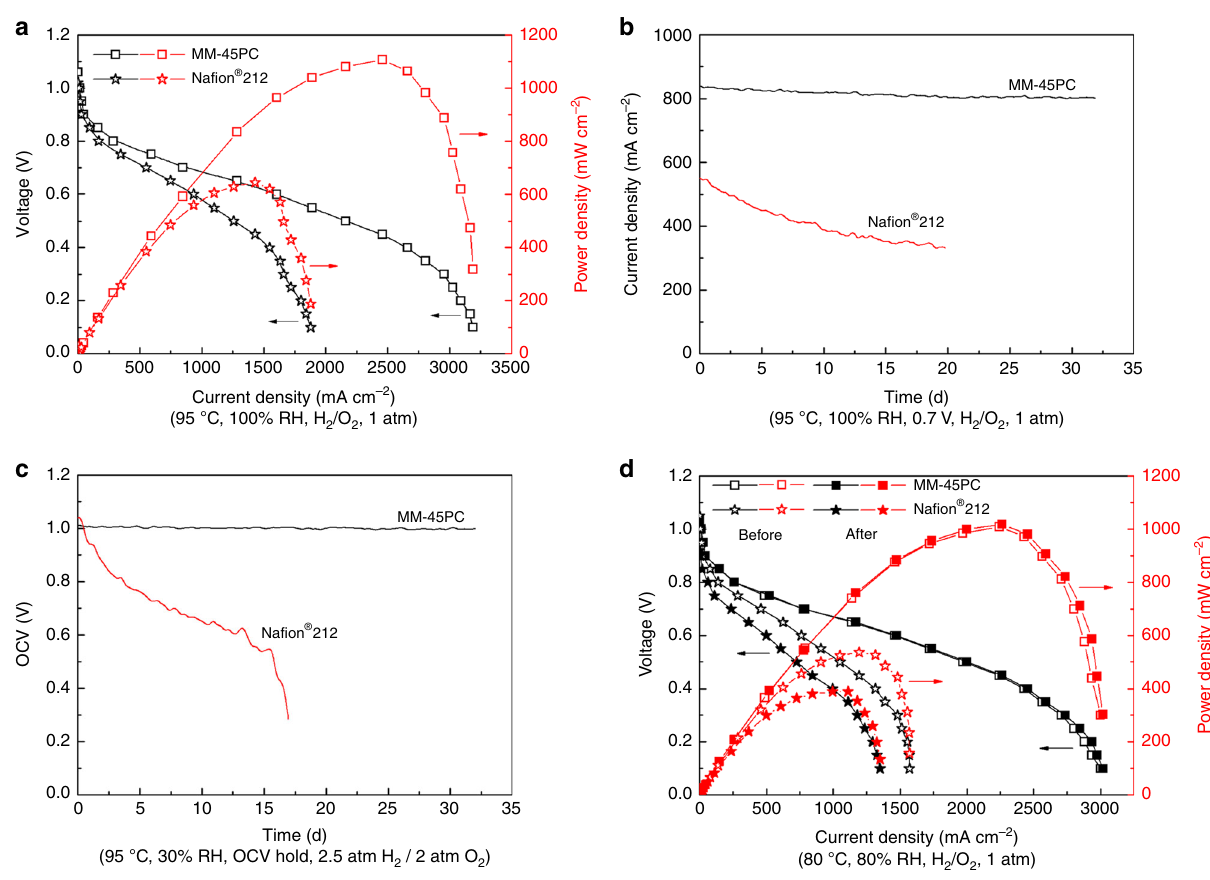
Fig. 10 Comparative performance and durability. PEMFC performance and durability derived from MM-45PC and Na fi on ® 212 are shown. a Single-cell polarization curves for PEMFCs operated at 95 °C under 100% RH. Compared with Na fi on ® 212, MM-45PC shows a signi fi cantly higher maximum power density. b Long-term durability of PEMFC at 95 °C under 100% RH for 32 days, with a constant voltage of 0.7 V. The MM-45PC PEMFC shows only a small decline of 4.1% in current density, much lower than the 40% loss of Na fi on ® 212 over 20 days. c Chemical AST of an OCV hold at 90 °C under 30% RH. The MM-45PC PEMFC shows a decline of 1.0% OCV for 32 days, re fl ecting the ef fi cient radical scavenging ability of ferrocyanide, while Na fi on ® 212 PEMFC exhibits catastrophic failure within 17 days. d Polarization curves before and after mechanical AST at 80 °C under 80% RH. The almost overlapped polarization curves of MM-45PC before and after mechanical AST indicate a higher mechanical stability compared with Na fi on ® 212. PEMFC: proton exchange membrane fuel cell; MM-45PC: magnetic-cast membrane with 45 wt% loading of proton-conducting components; OCV: open circuit voltage; AST: accelerated stress test; RH: relative humidity. Source data are provided as a Source Data fi